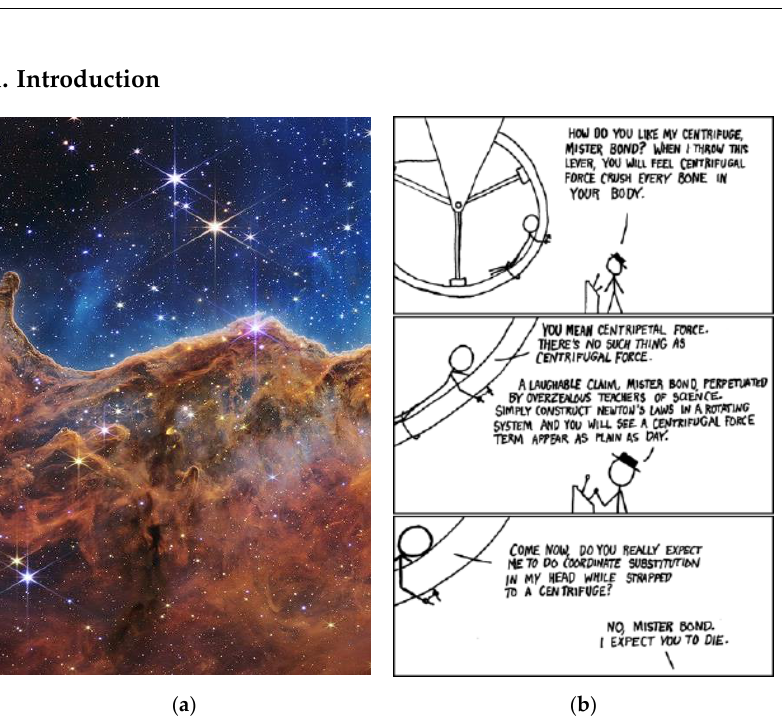
Figure 1. ( a ) First images from the James Webb Space Telescope peering into deep space where the “inertial”, non-moving reference frame is often mathematically placed; credits: NASA, ESA, CSA, and STSc [1]. ( b ) NASA humor over the ubiquity of the difficulty of learning kinematics [2]. Image usage is consistent with NASA policy, “NASA content (images, videos, audio, etc.) are generally not copyrighted and may be used for educational or informational purposes without needing explicit permissions”